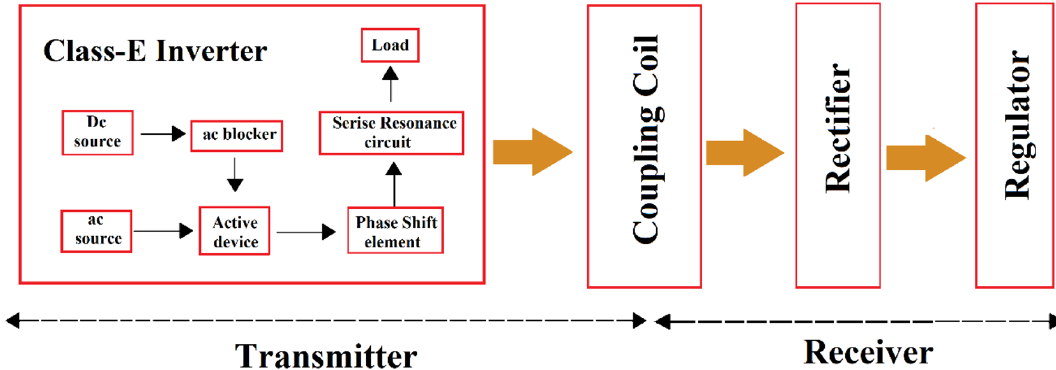
Figure 2. The proposed block diagram of a WPT in biomedical implants.